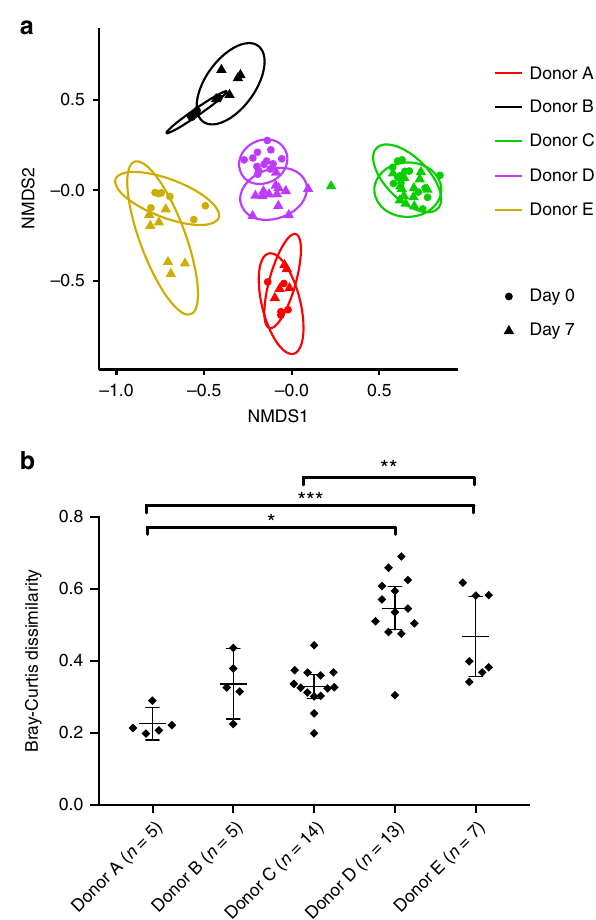
Fig. 4 Differences in microbiome stability during arsenic exposure. a Non- metric multidimensional scaling of Bray – Curtis dissimilarity illustrates both within and between group as well as within and between exposure time changes in microbiome diversity. Each point represents a single humanized mouse microbiome according to donor (color) and time-point (symbol). Ellipses represent 95% con fi dence. Microbiomes were more similar within donor groups than between ( p = 0.001, ANOSIM), and in all donor groups, day 7 microbiomes were signi fi cantly different from baseline (day 0) microbiomes ( p ≤ 0.009, ANOSIM; Supplementary Table 5). b Stability of humanized mouse microbiomes during iAs V exposure (mean and 95% con fi dence interval) was signi fi cantly different between groups as